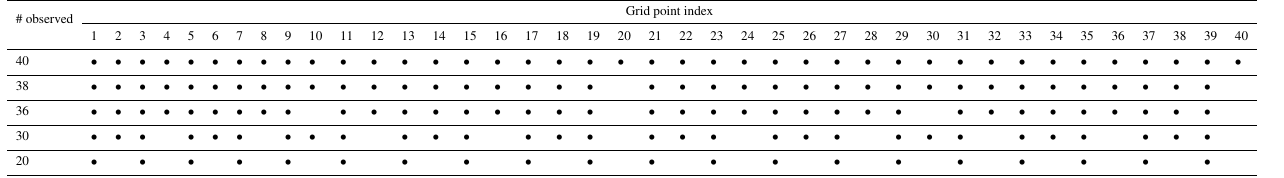
Table 3. The indices of observed grid